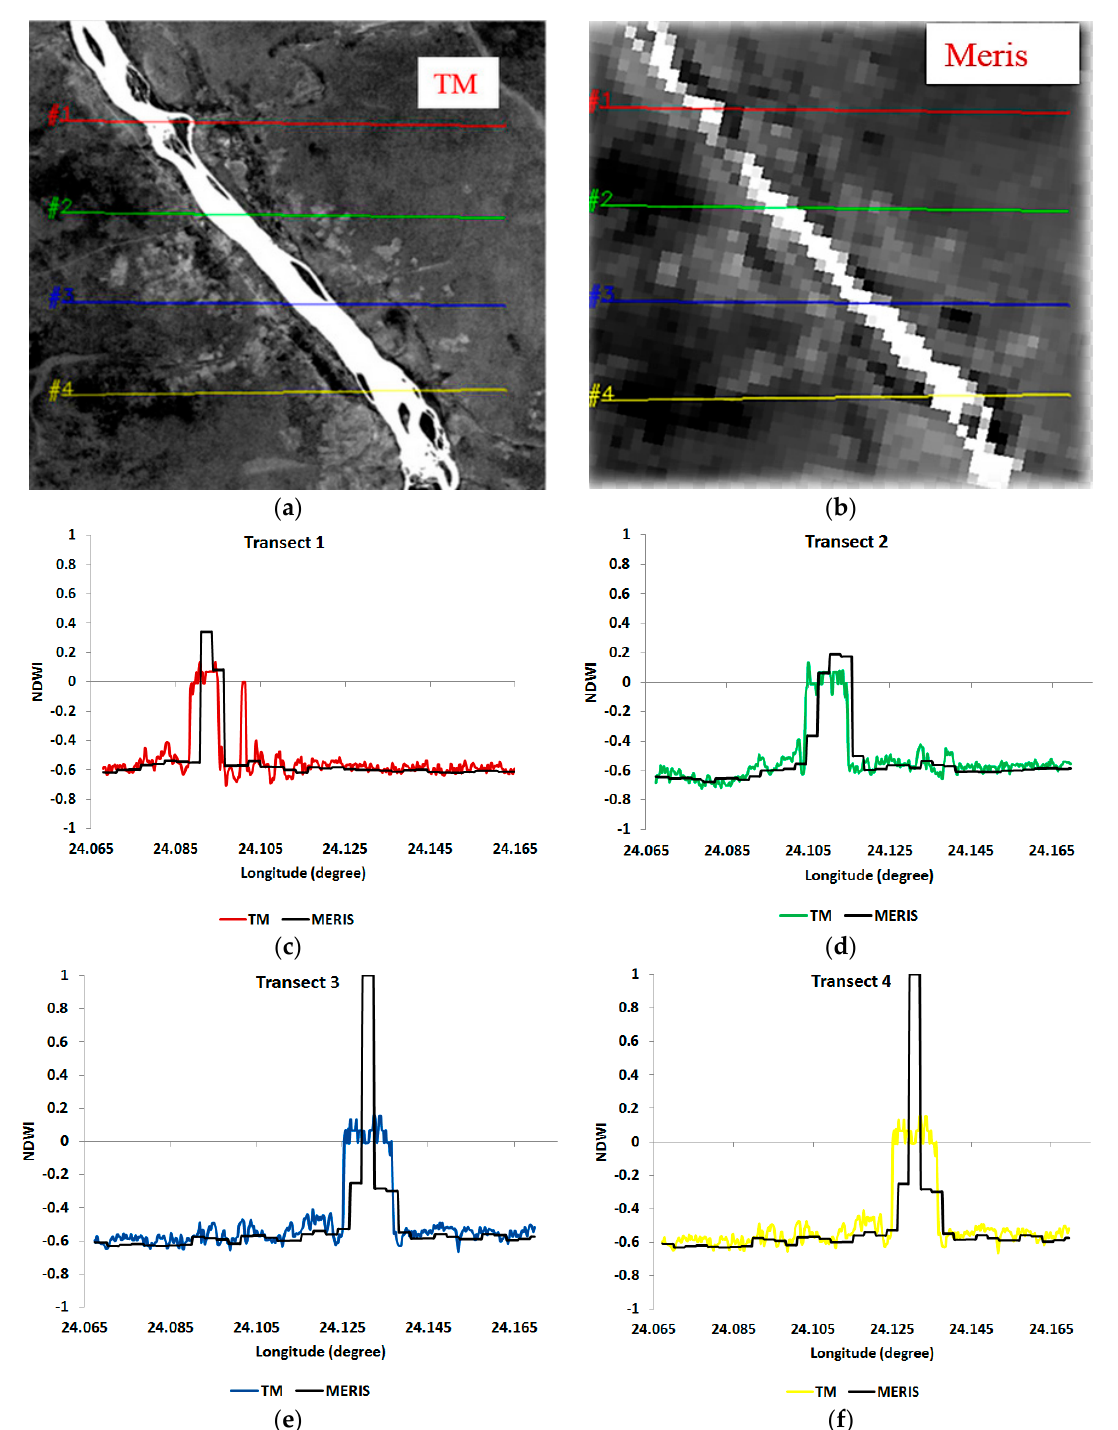
Figure 3. NDWI calculated from ( a ) TM and ( b ) MERIS images acquired on 17 April 2008 as sampled along four transects ( c – f ).